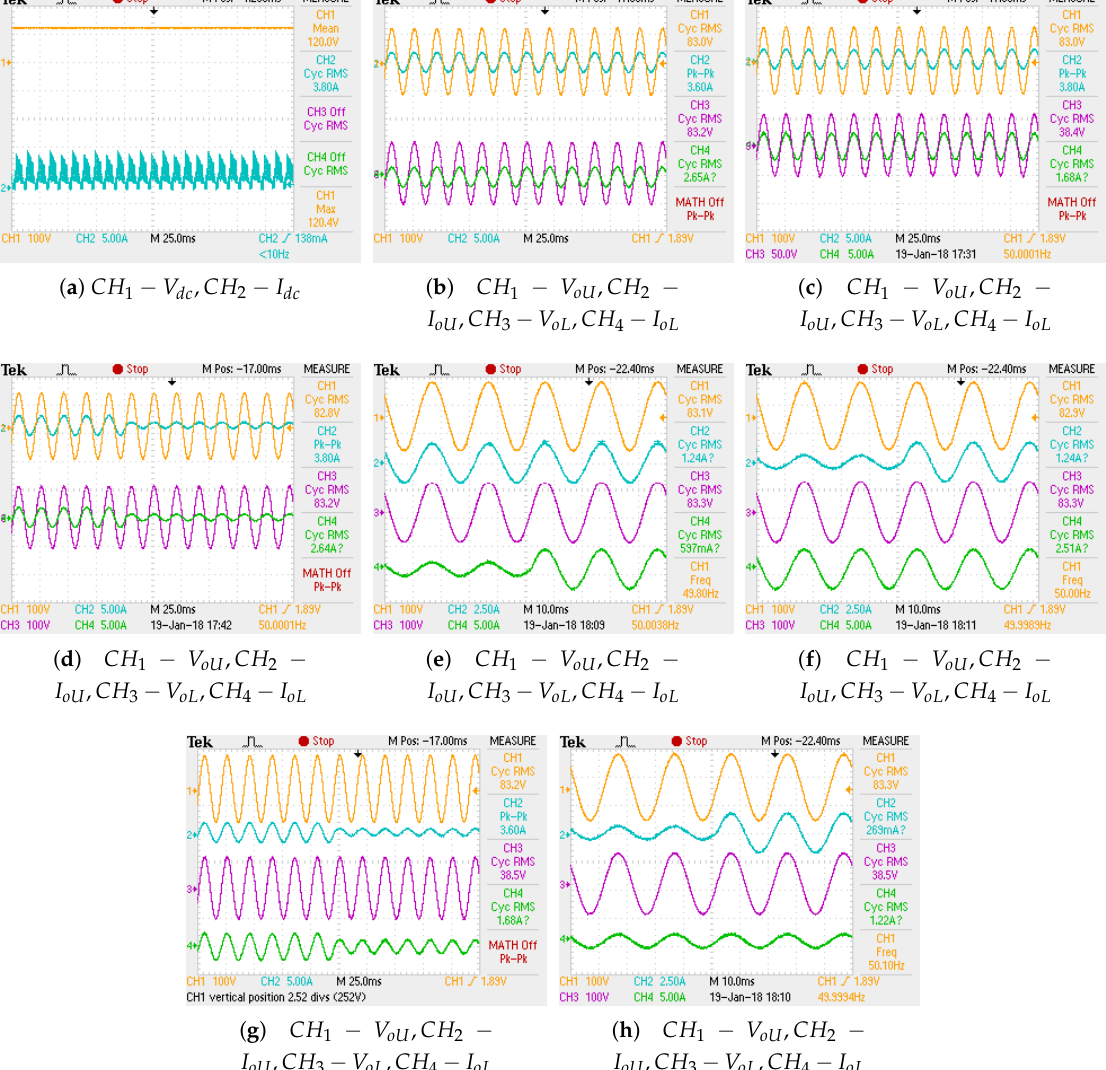
Figure 7. Prototype Results: ( a ) DC voltage and current, ( b ) EV mode output voltage and load current, ( c ) DV mode output voltage and load current, ( d ) EV mode output voltage and load current with step change, ( e ) EV mode output voltage and load current with step change in lower load, ( f ) EV mode output voltage and load current with step changes in upper load, ( g ) DV mode output voltage and load current with step changes in load, ( h ) DV mode output voltage and load current with step